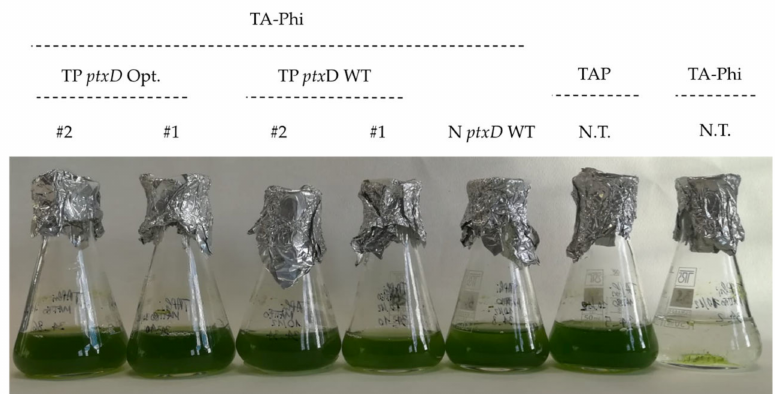
Figure 2. Growth of selected transformant lines in TA-Phi (phosphite-supplemented) medium. Two independent transplatomic lines carrying the wild type PTXD (TP ptxD WT) and mutagenized (TP ptxD Opt) versions, respectively, were included, along with the nuclear transformant (N ptxD WT)